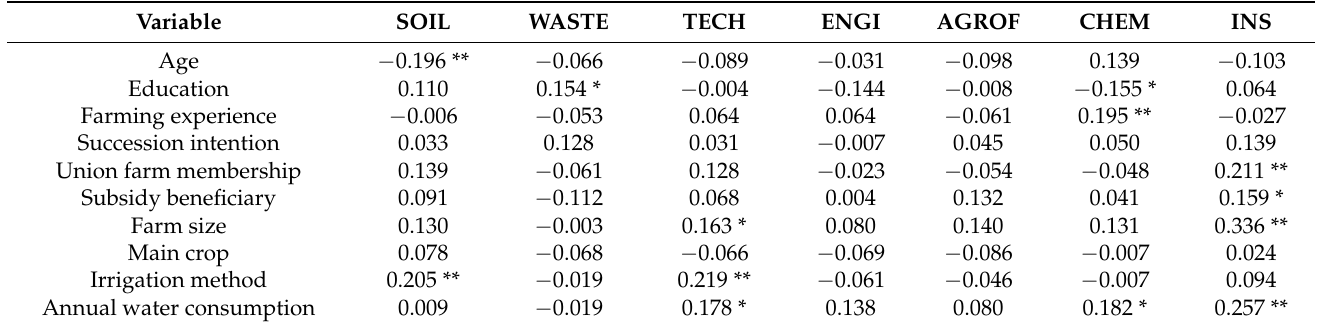
Table 8. Sociodemographic drivers of climate change adaptation measures.